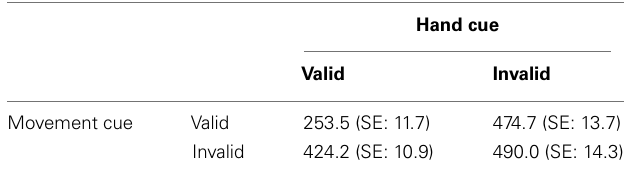
Table 1 | Mean reaction time in milliseconds for each cue